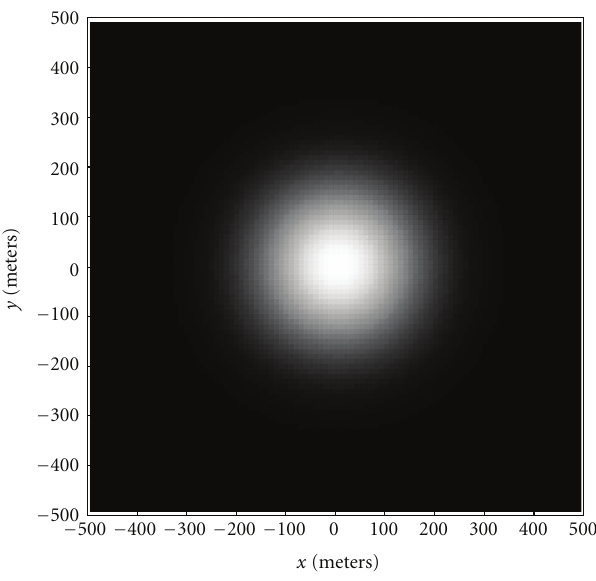
Figure 10: A sample computation of local expected number of targets I r over a surveillance area when the underlying target density distribution is a simple Gaussian probability distribution. Notice that local expected number of targets acts as a smoothing filter over the target density distribution.